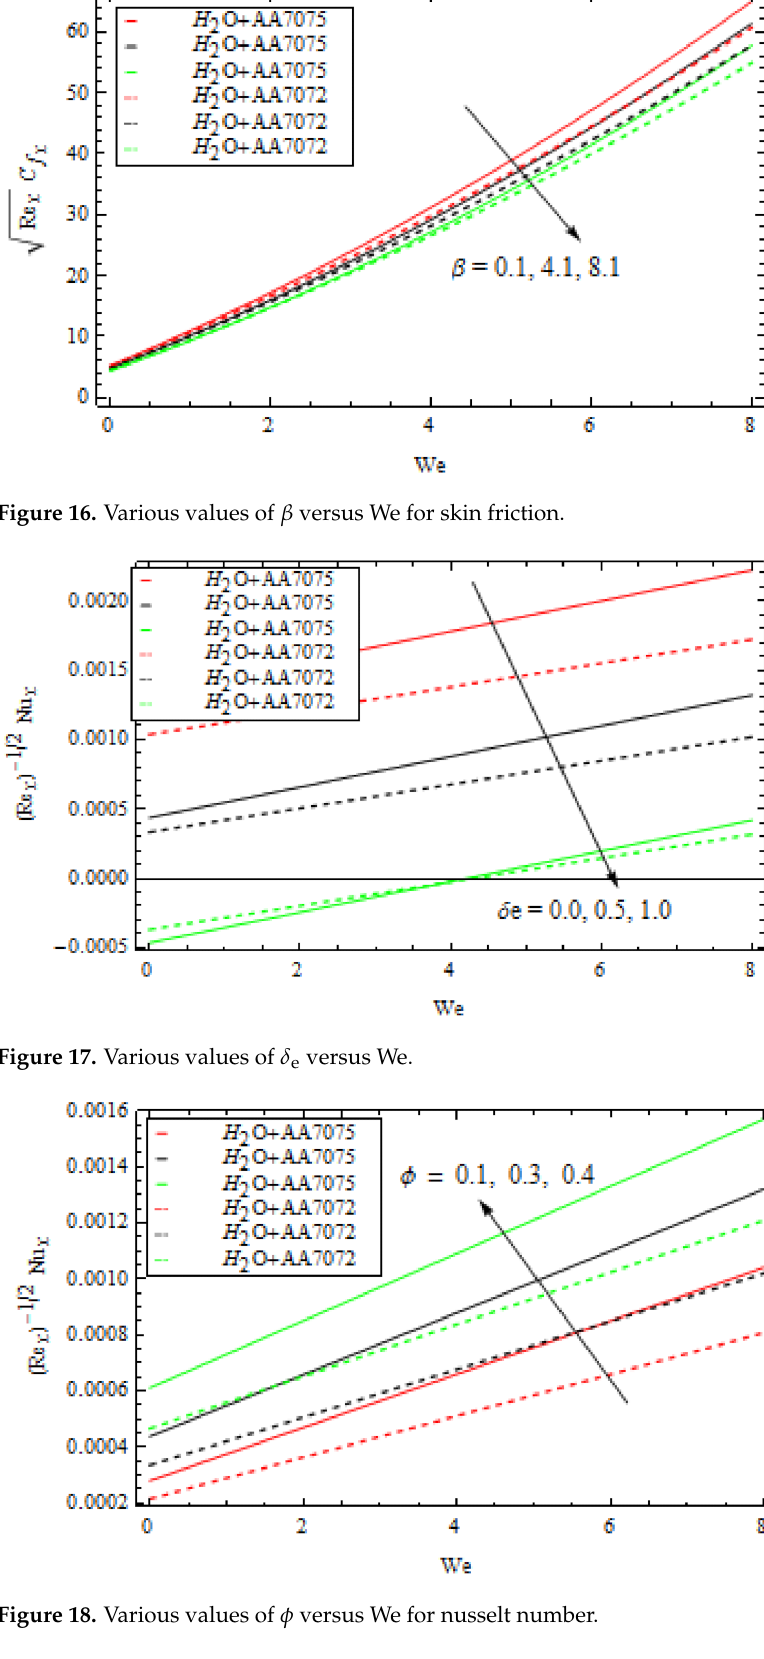
Figure 18. Various values of φ versus We for nusselt